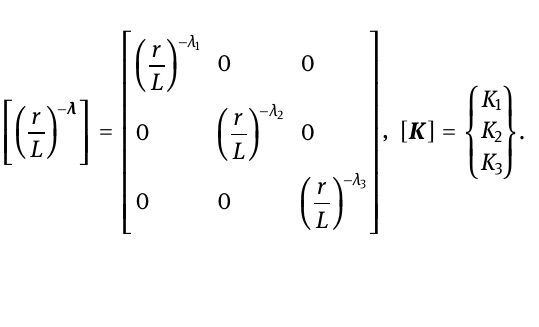
Figure 1: Analytical Models: ( a ) Model - 1 and ( b ) Model -